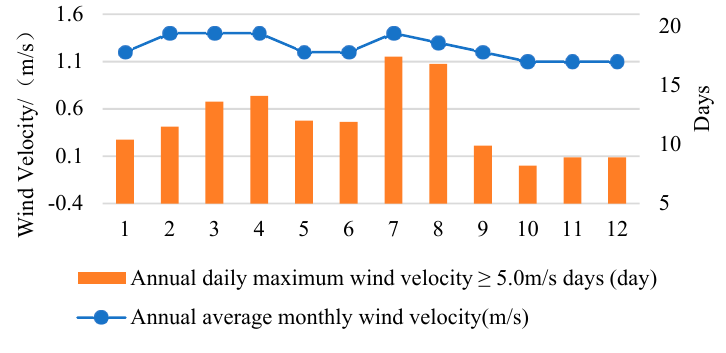
Figure 11. Wind speeds each month in Jinyun County.